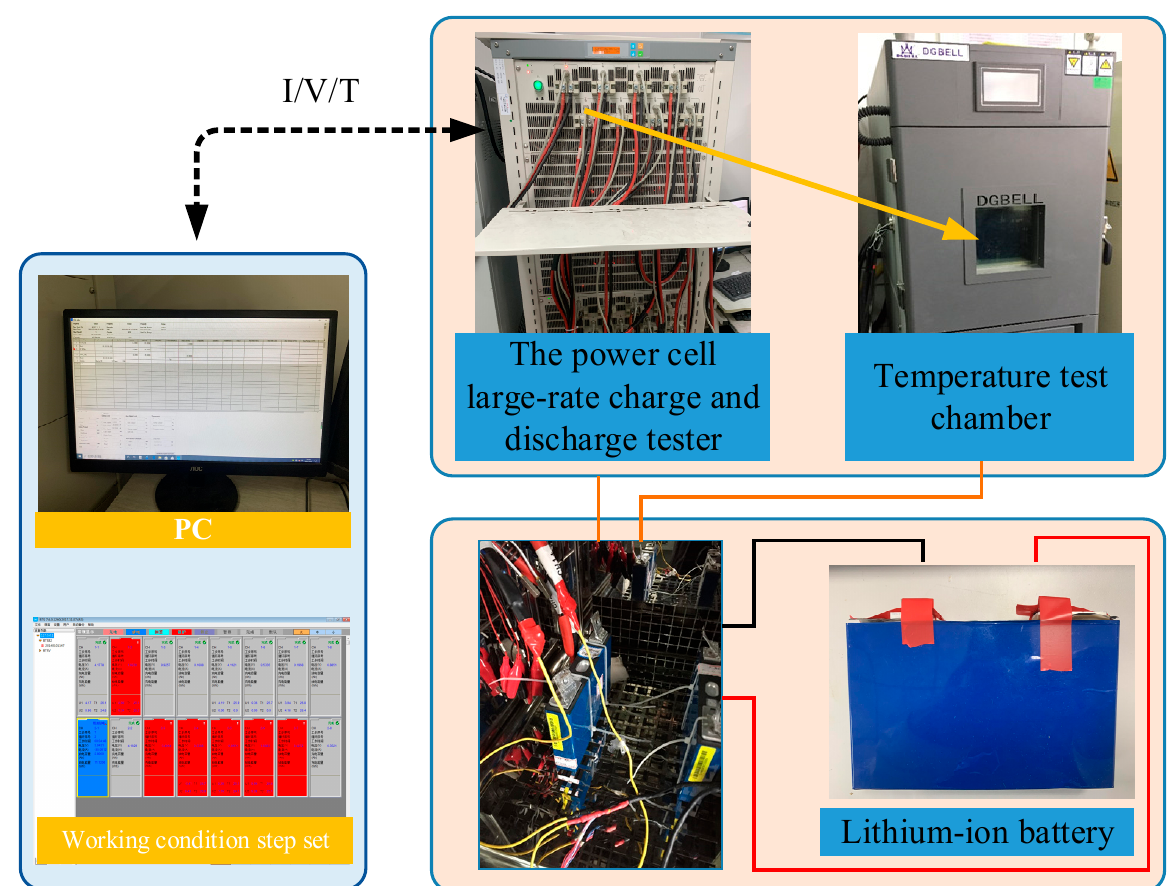
Figure 4. Experiment platform.